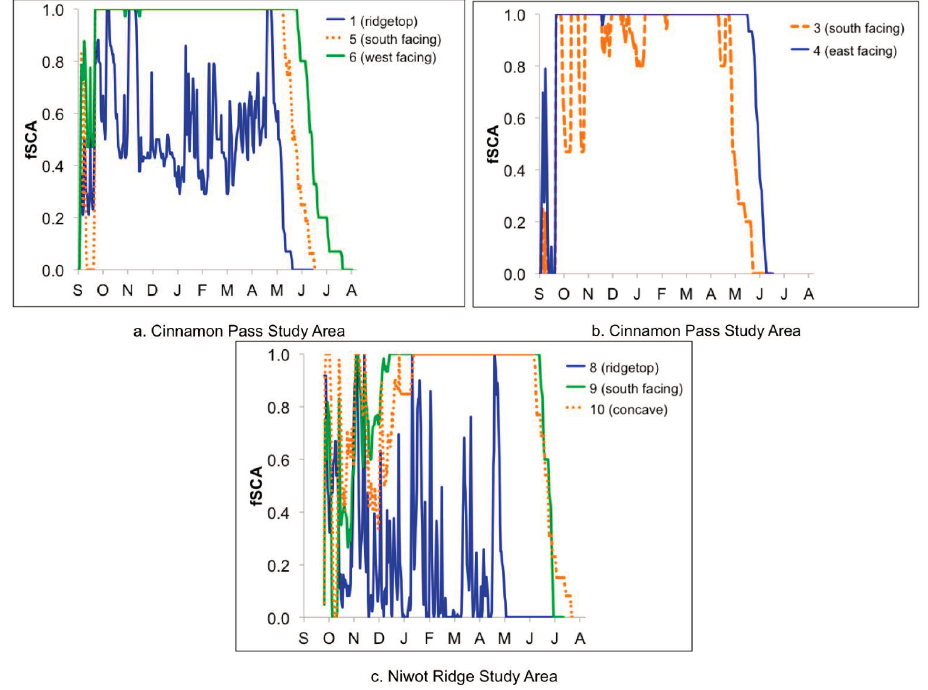
Figure 13. Daily 60 m grid cell snow cover fraction time series from ( a ) grid cells 1, 5, and 6 at Cinnamon Pass FSA ( b ), grid cells 3 and 4 at Cinnamon Pass FSA, and ( c ) grid cells 8, 9, and 10 at Niwot Ridge FSA. Time series depicted in the same panel are all from grid cells within 500 m and could thus be contained within a single 500 m MODIS grid cell. Time series from the two 60 m grid cells not shown are similar to #1 (south facing) in panel (a) and #8 (ridgetop) in panel